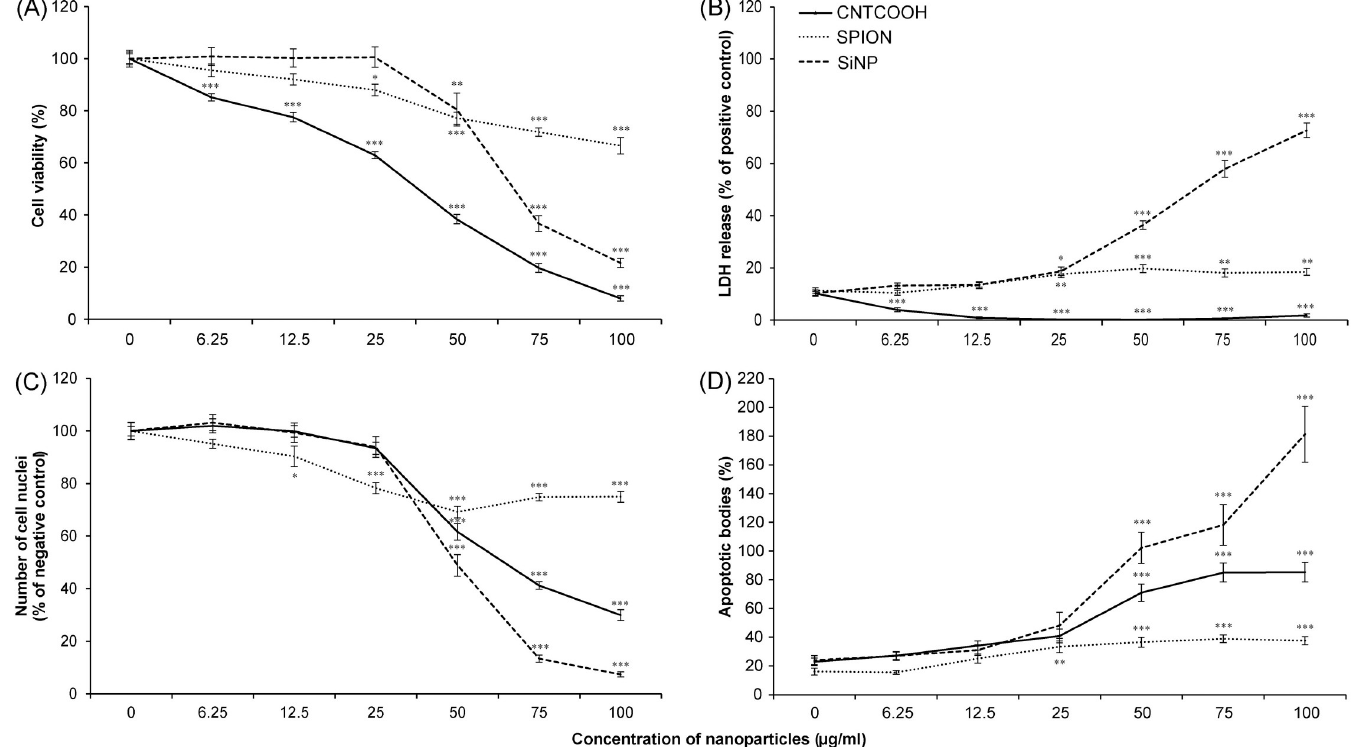
Fig 5. Dose-dependent toxicity of diverse NPs towards HUVECs as measured by CDS assay. The HUVECs in the 96-well plate were treated with 0–100 μ g/ml of SiNP, SPION or CNTCOOH NPs for 24 hours. The cell viability was measured by WST-8 assay (A), the cell necrosis was gauged by LDH assay (B), and the number of intact cell nuclei (C) and number of apoptotic bodies (D) were counted by ImageJ software after staining the cells with Hoechst 33342. Each measurement was performed in 6-plicate, and the results (n = 3) are expressed as the means ± SEM as tested by one-way ANOVA followed by Dunnett’s test. ��� P < 0.001, �� P < 0.01, and � P < 0.05, versus the negative control specific for each